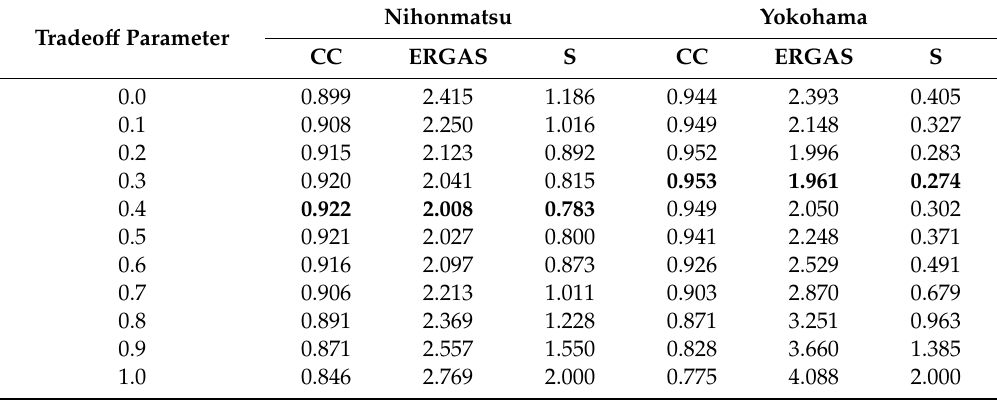
Table 3. CC, ERGAS, and the evaluation index S that determines the tradeo ff parameter. The best values are given in bold.